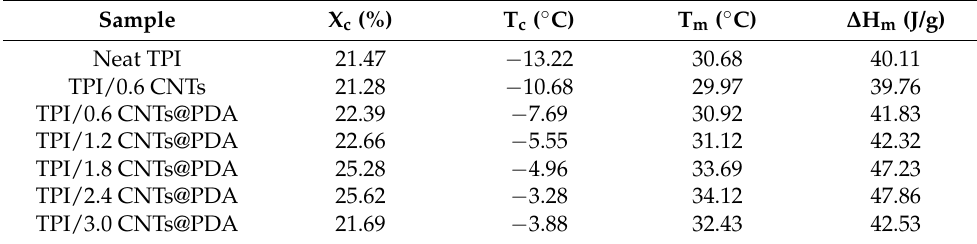
Figure 7. DSC curves of TPI composites: ( a ) cooling curves and ( b ) heating curves. Table 2. DSC crystallization parameters of TPI composites.